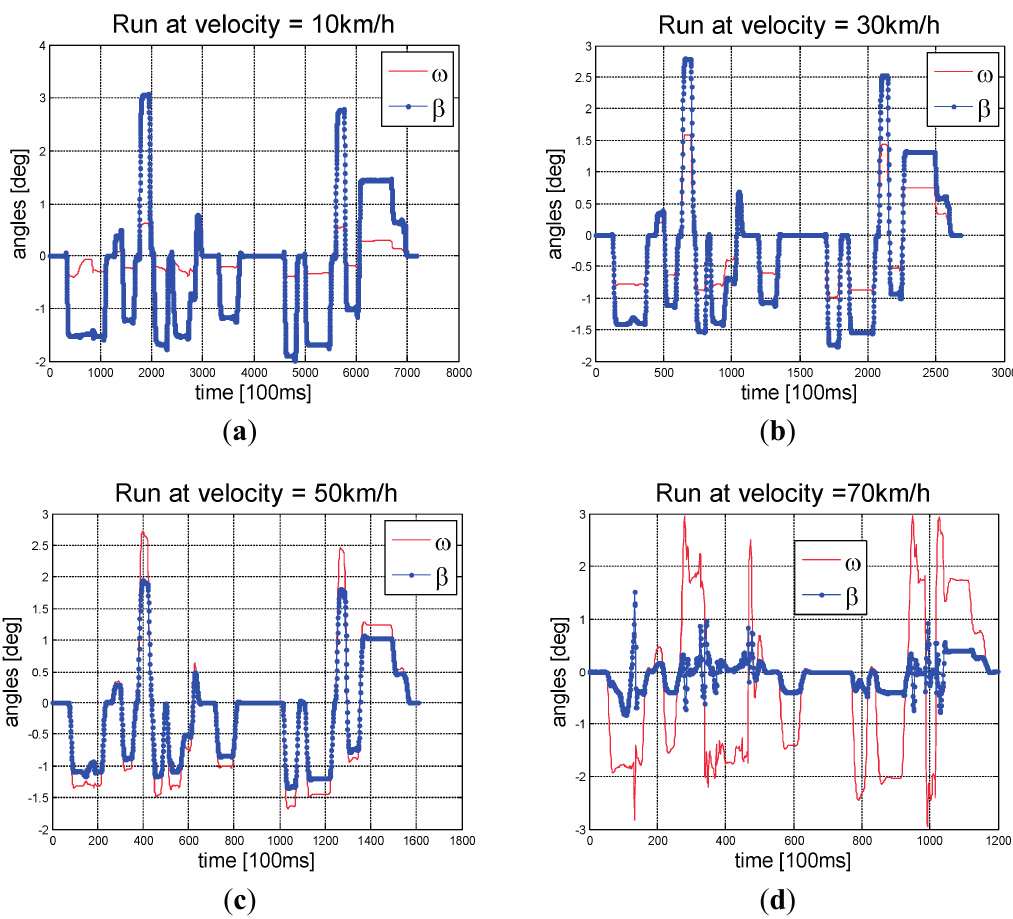
Figure 3. Plots of yaw angle increment ω (at 100 ms interval) and side slip angle β using CarSim simulated data. Velocity changes from 10 km/h to 70